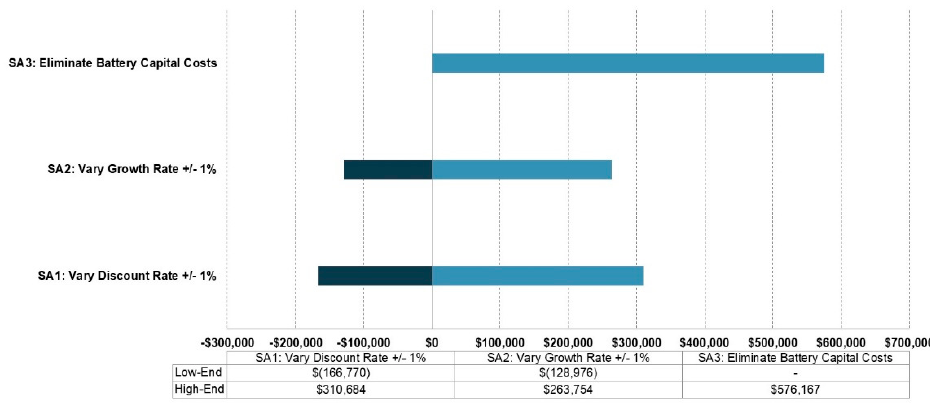
Figure 14. Sensitivity analysis results.